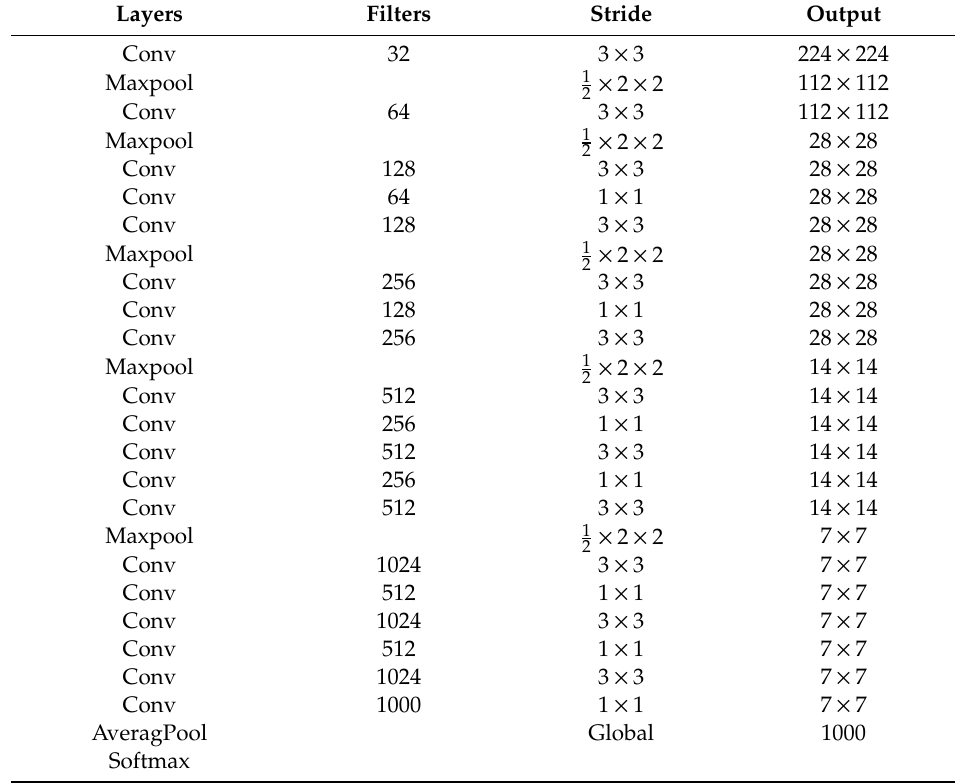
Table 1. The human detector takes advantage of the YOLOv3 model, which extracts the related bounding boxes containing the ROI